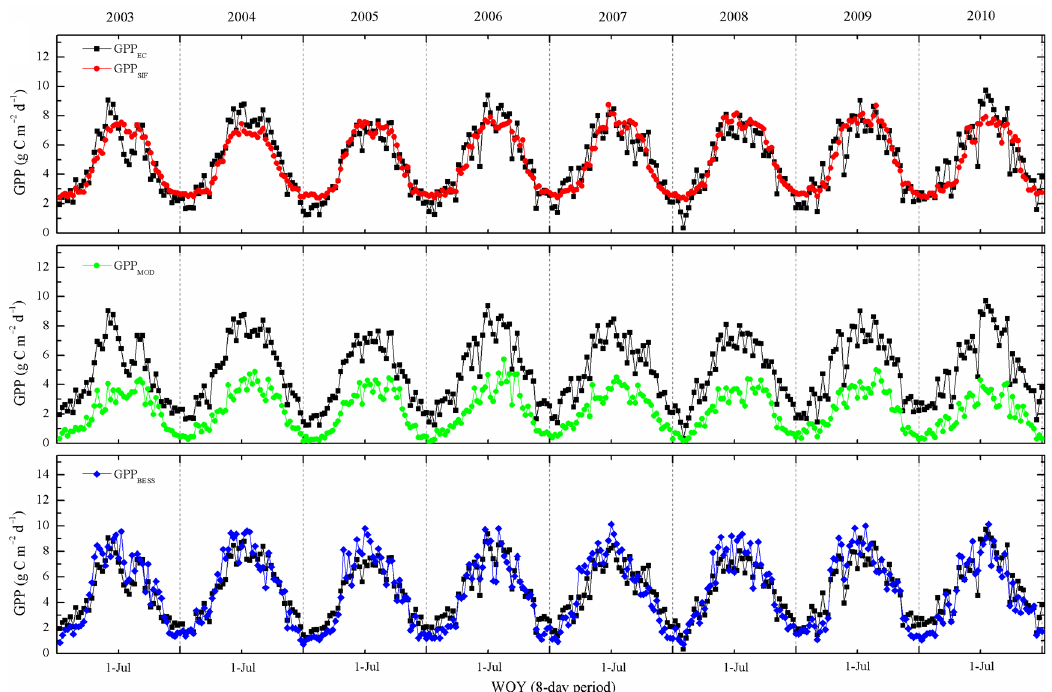
Figure 7. Seasonal consistency between tower-based GPP observations (GPP EC ) at the QYZ flux site (evergreen needleleaf forest) and three different satellite-based GPP products including the SIF-based GPP (GPP SIF ), MODIS GPP (GPP MOD ), and BESS GPP (GPP BESS ), respectively.